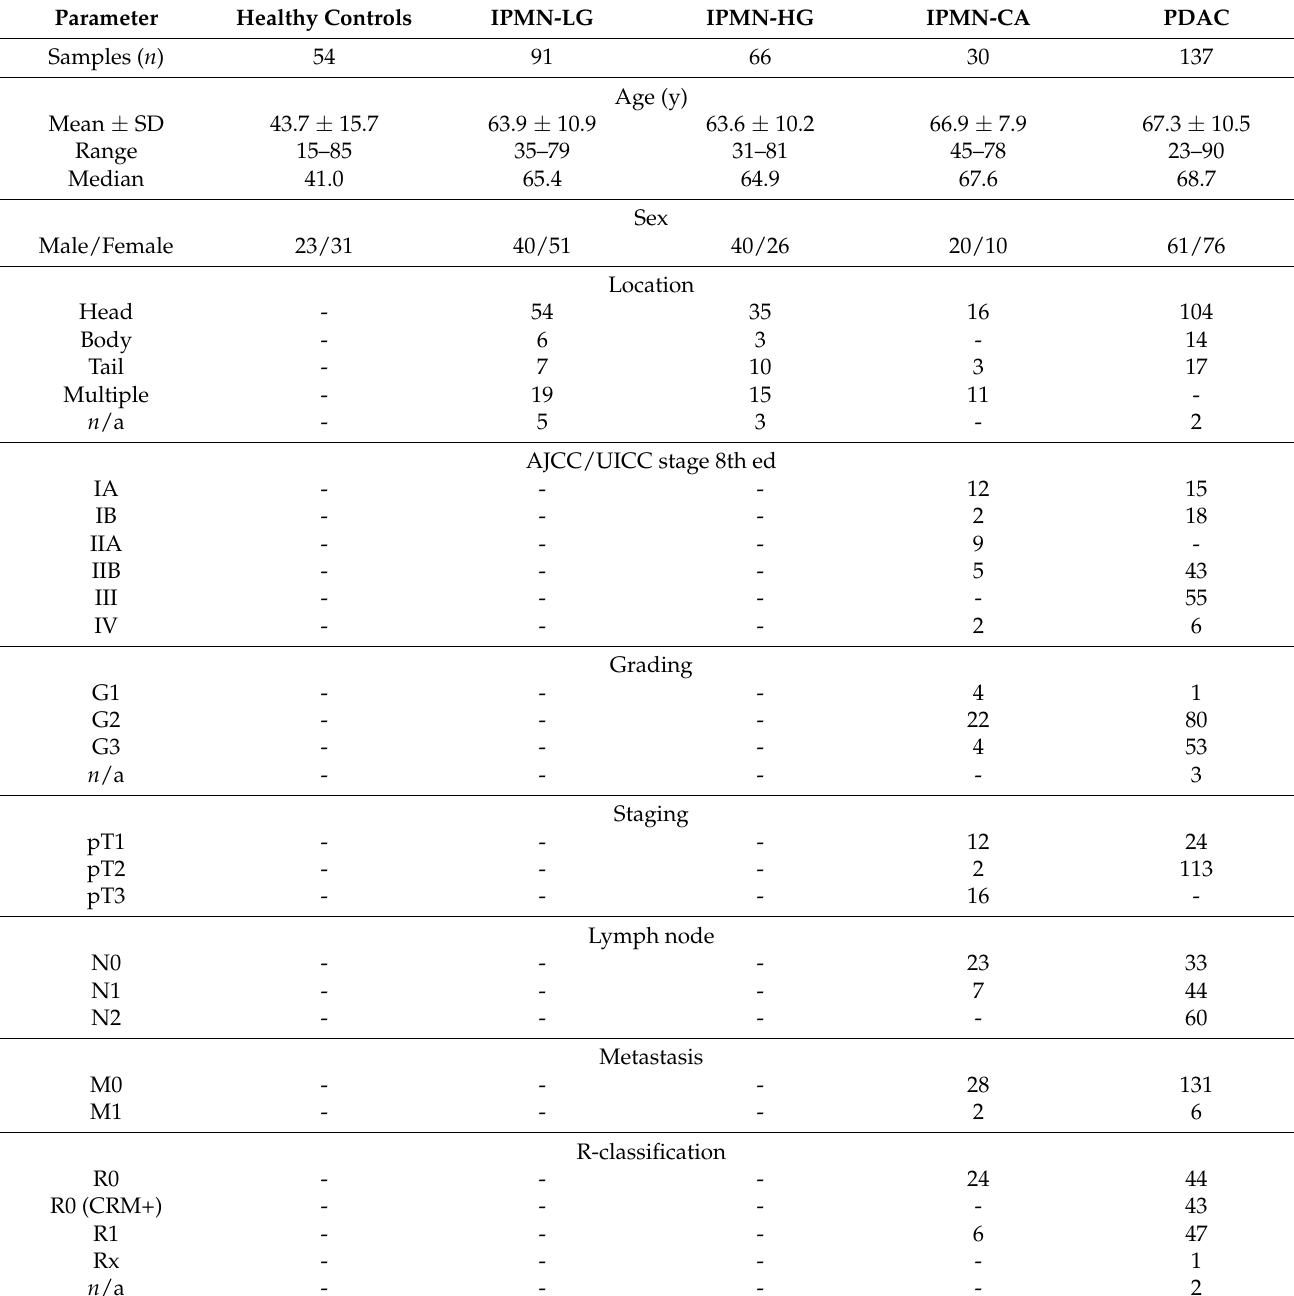
Table 1. Clinicopathological parameters of IPMN and PDAC